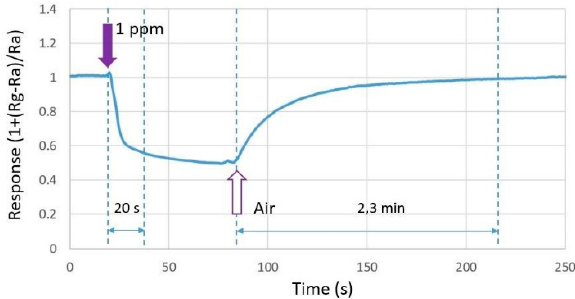
Figure 5. Response time and recovery time of the composite heater design to 1 ppm of